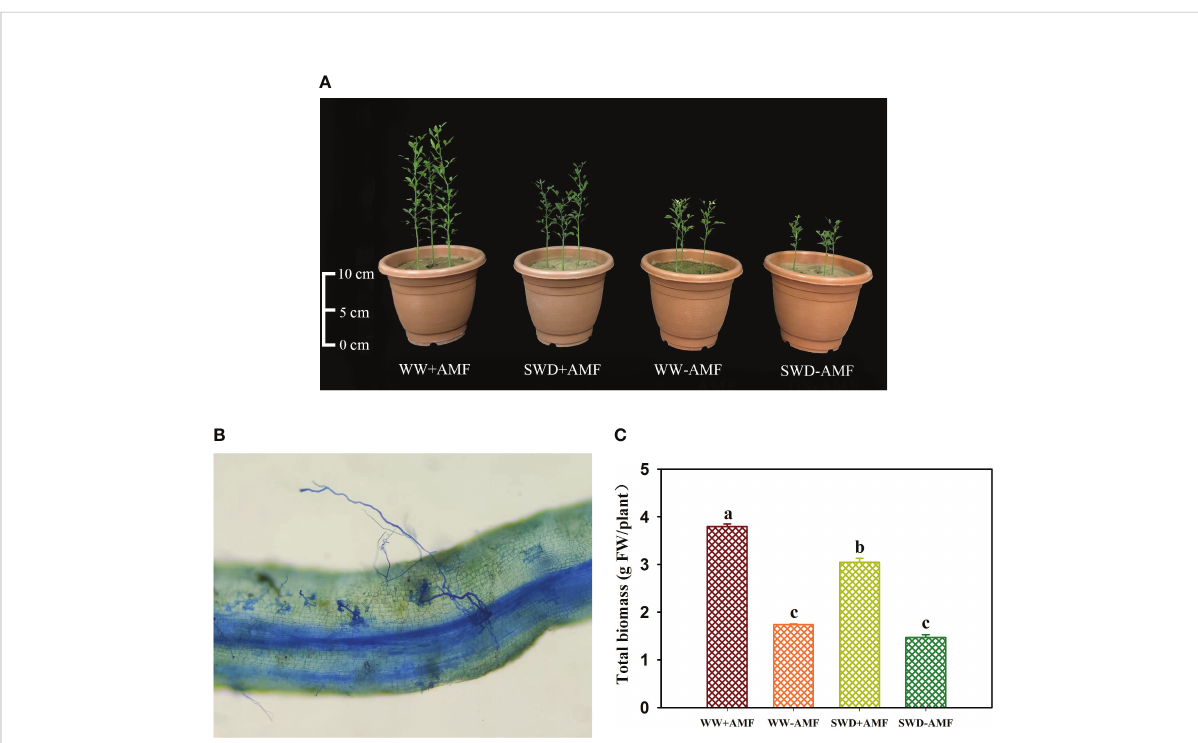
FIGURE 5 Changes in plant growth performance (A) , root mycorrhizal colonization (B) , and total biomass (C) of trifoliate orange in response to soil water de fi cit and Funneliformis mosseae inoculation. Abbreviations: WW+AMF, plants inoculated with F mosseae under well-watered; WW-AMF, plants inoculated without F mosseae under well-watered; SWD+AMF, plants inoculated with F mosseae under soil water de fi cit; SWD-AMF, plants inoculated without F mosseae under soil water de fi cit. Data (means ± SD, n = 4) followed by different letters above the bars indicate signi fi cant ( P < 0.05) differences between